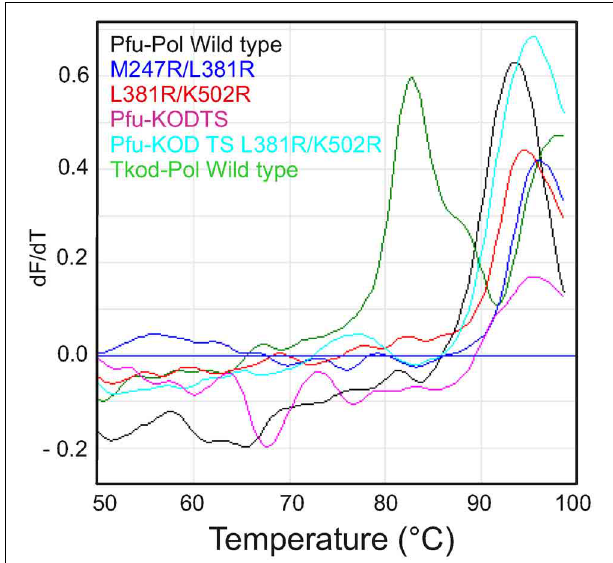
FIGURE 8 | Differential scanning fluorimetry (DSF) profiles describing the thermal unfolding of the polymerases. The first derivatives of the DSF profiles are shown with dF / dT indicating the change in fluorescence (relative units). Individual polymerases are identified by the color coding given in the